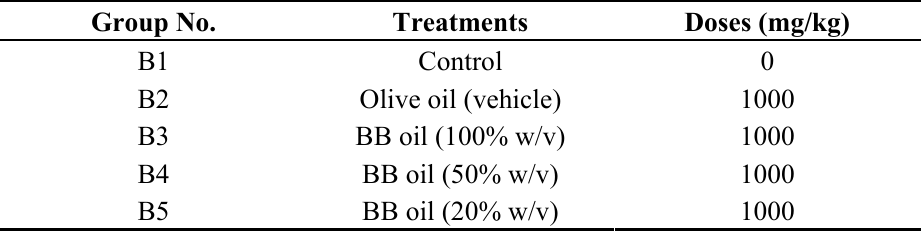
Table 3. Wound animal groups ( n = 5/group): treatments, doses and route of administration of different concentrations of volatile oil from Blumea balsamifera (BB oil)